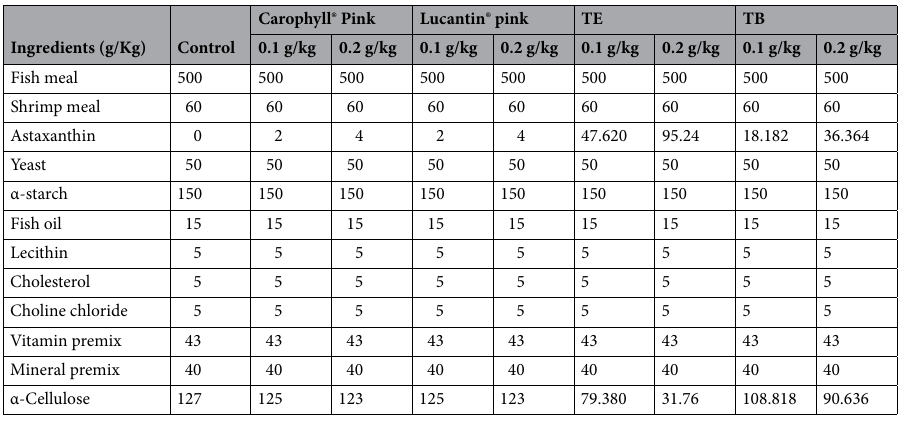
Table 1. Composition and proximate contents of the experimental